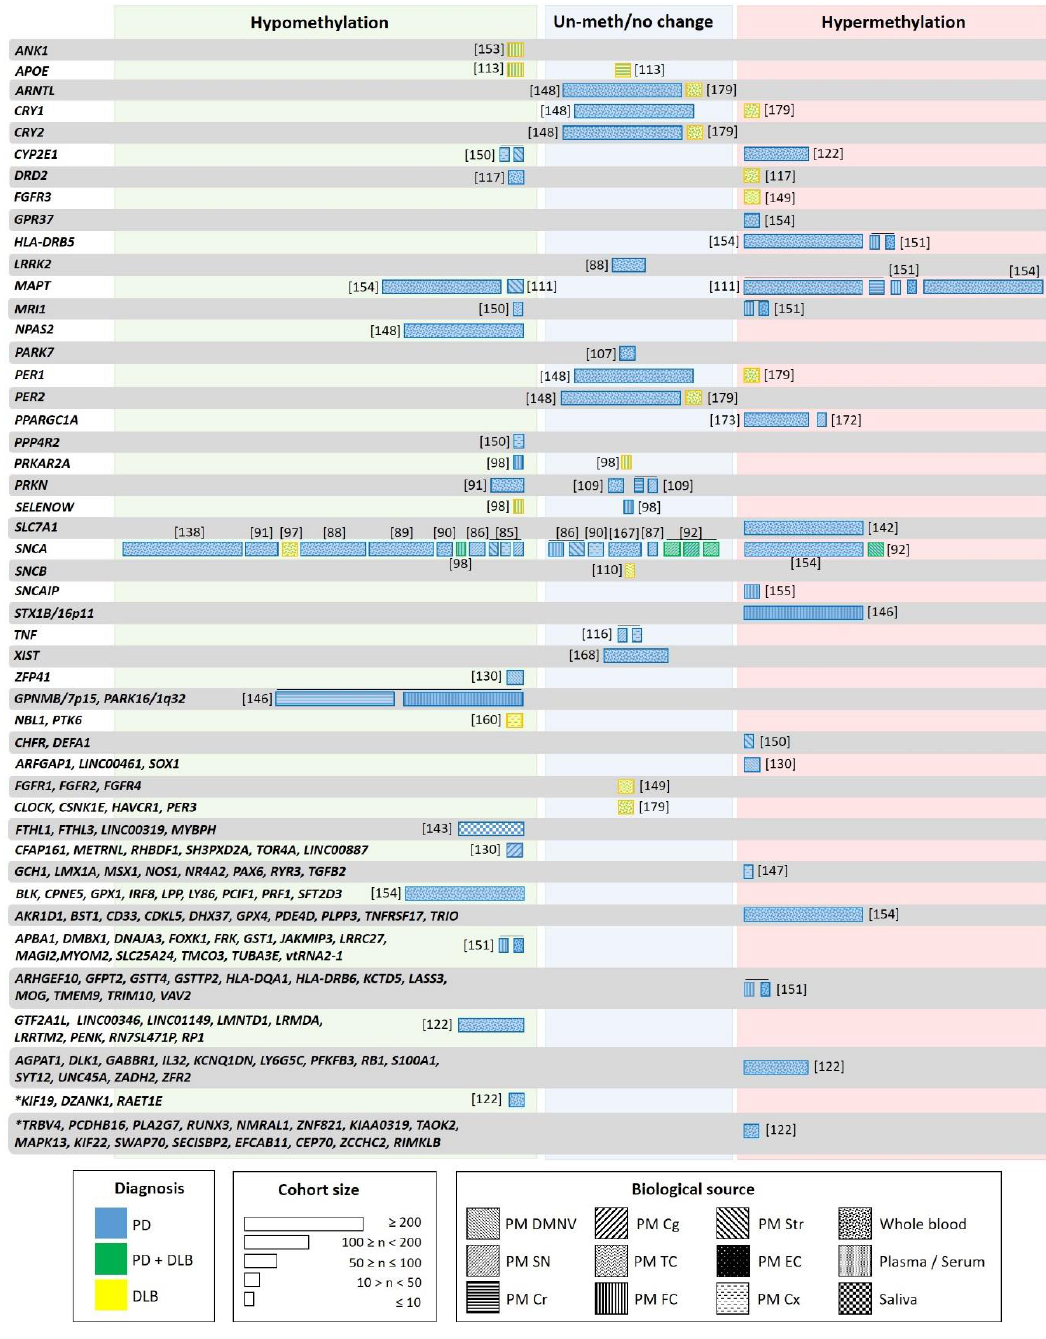
Figure 2. Genes studied for differential methylation in patients with LBD. Each box indicates one individual study, with width proportional to the sample size of each study. The color of the boxes indicates the patient type: blue — PD; yellow — DLB; green — PD and DLB. Box patterning shows the biological source used in each study: Postmortem dorsal motor nucleus of the vagus (PM DMNV), substantia nigra (SN), cerebellum (Cr), temporal cortex (TC), frontal cortex (FC), Striatum (Str), entorhinal cortex (EC), cortex (Cx), whole blood, plasma/serum, peripheral blood and saliva. Asterix indicates genes with longitudinal changes in methylation in patients not receiving L-dopa / entacapone. Another alteration confounding the relationship between the disease and epigenetics is blood cell composition, which di ff ers significantly between PD cases. Correspondingly, many of the